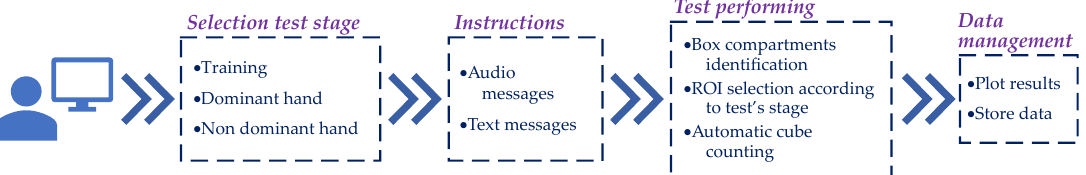
Figure 6. Flowchart for the test administration. The ABBT executes the appropriate sequence according